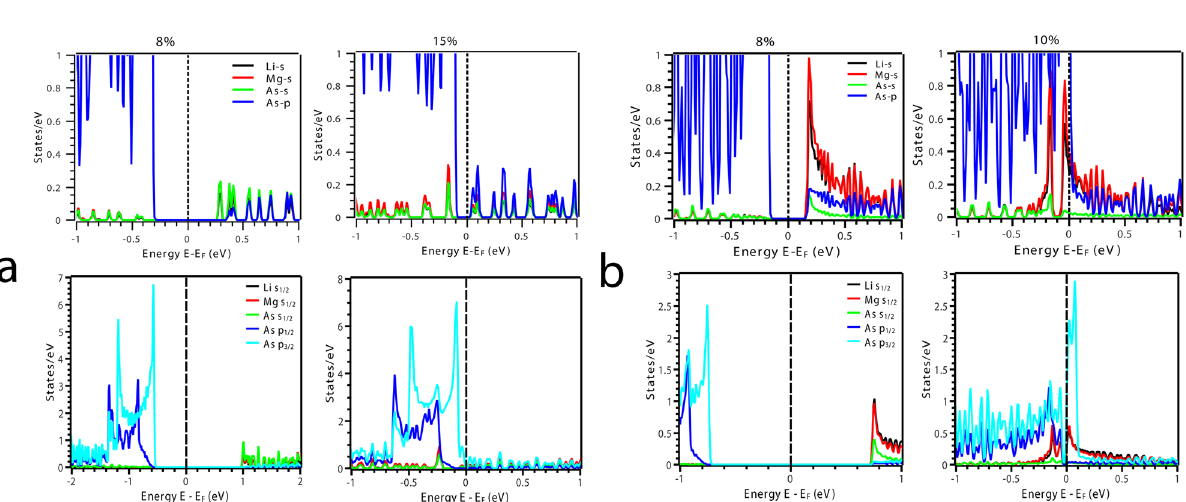
Figure 5. ( a ) Partial Density of States (PDOS) of the bulk phase of LiMgAs and ( b ) the low-dimensional [111] phase of LiMgAs (Top panel: without SOC, Bottom panel: with SOC) before and after critical pressure/strain indicating exchange of orbital contributions and orbital parity around